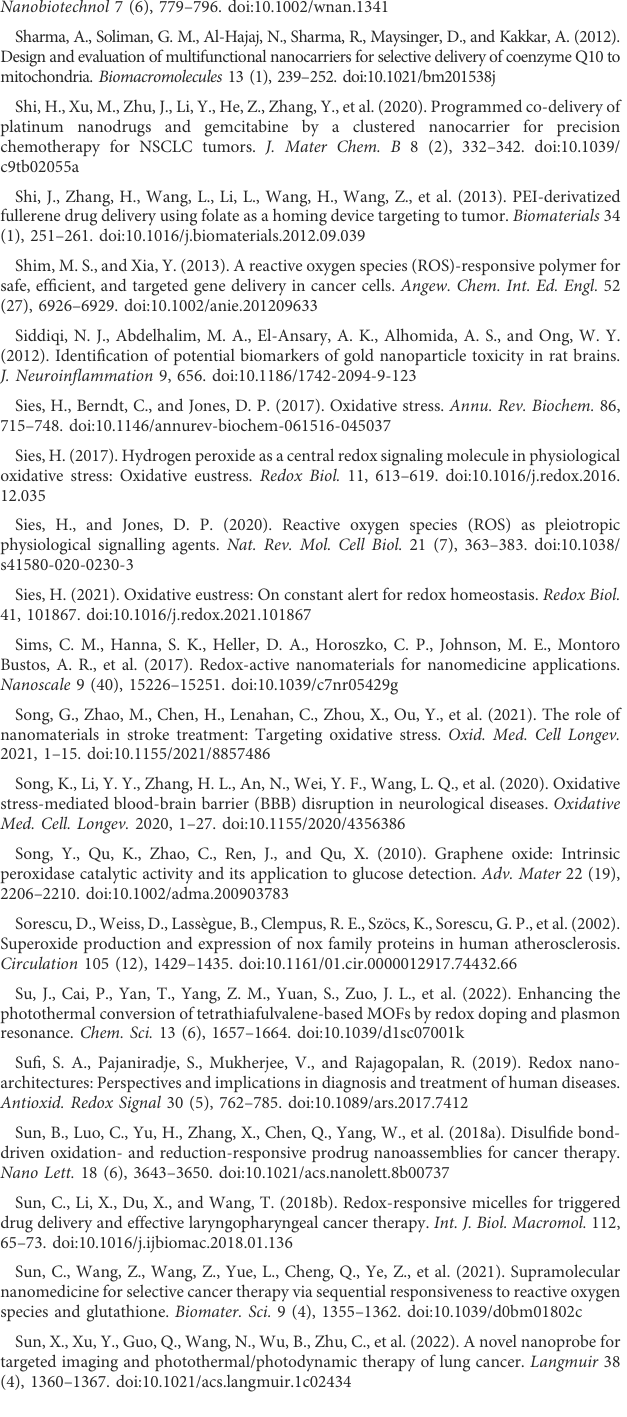
Tabatabaei, S. N., Girouard, H., Carret, A. S., and Martel, S. (2015). Remote control of the permeability of the blood-brain barrier by magnetic heating of nanoparticles: A